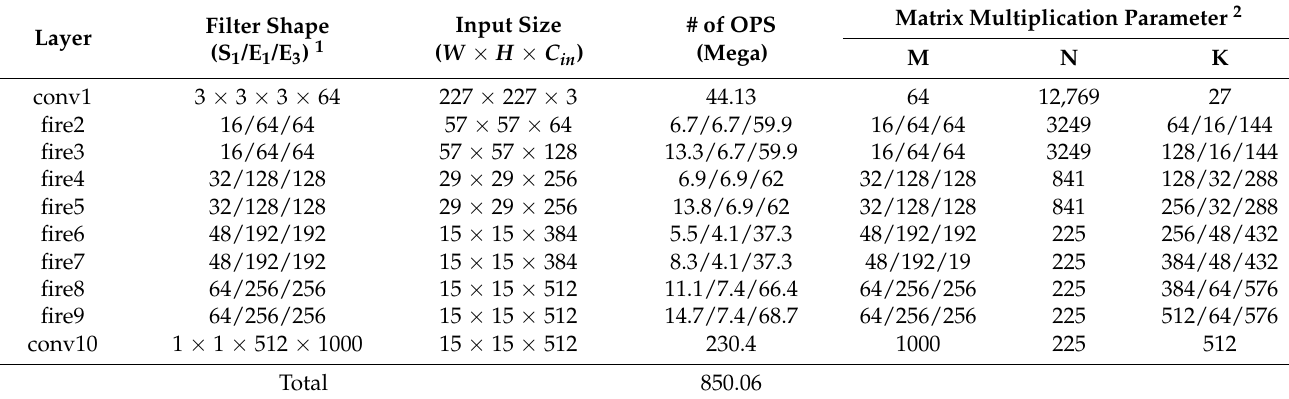
Table 8. Computation of SqueezeNet v1.1 [4] by matrix multiplication.